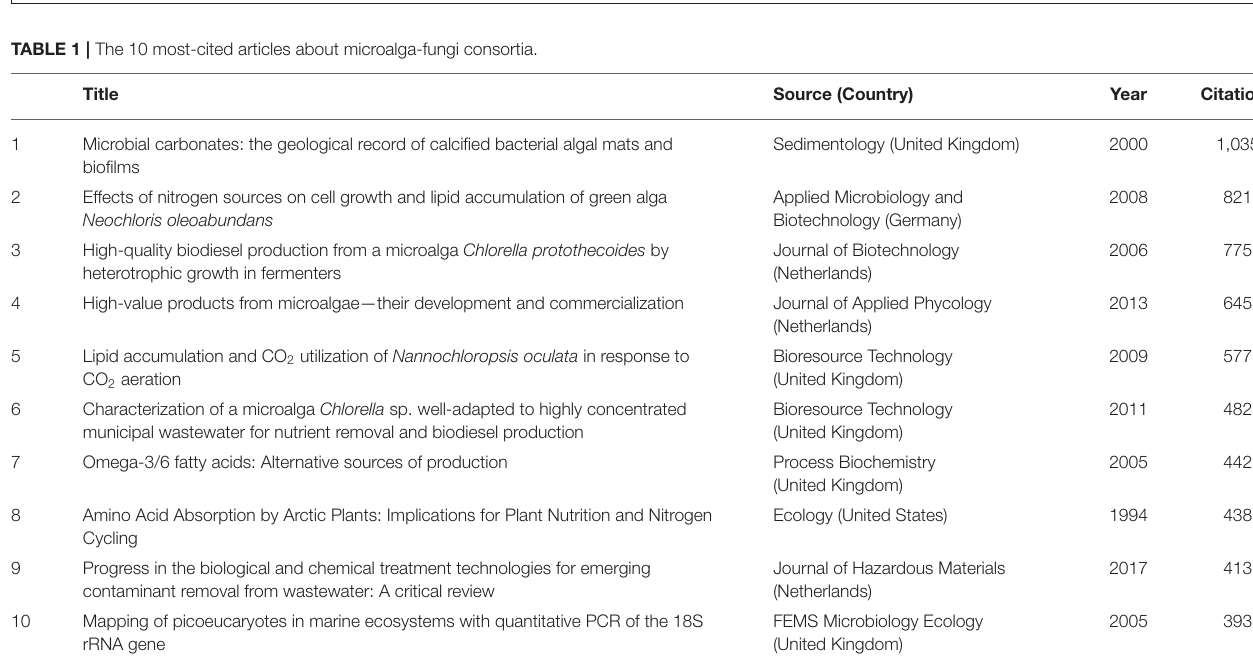
Figure 4 . Most of the authors started to publish on the subject after